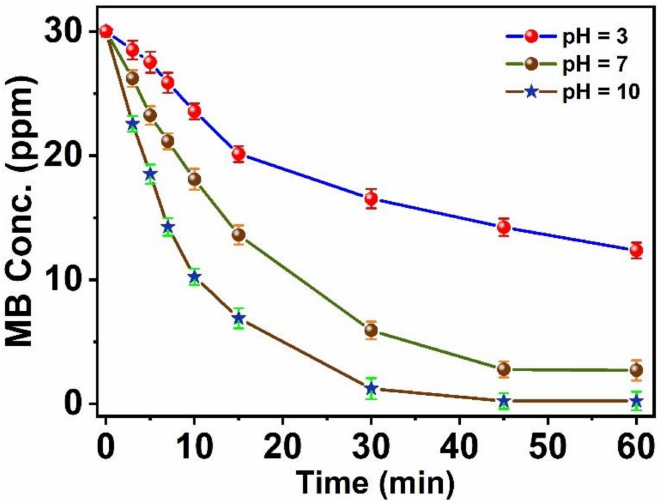
Figure 10. pH effect on the MB degradation process based on RuZnO@g-C 3 N 4